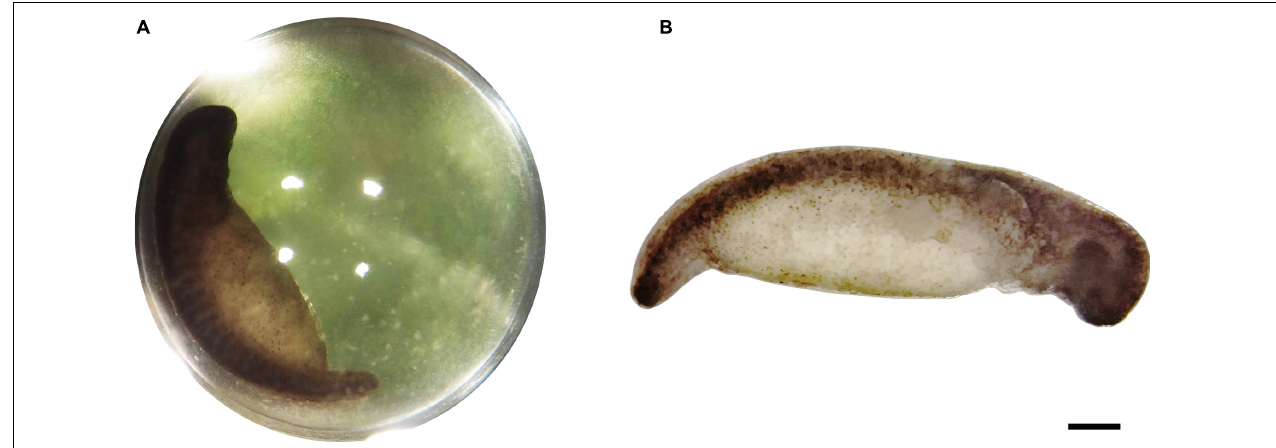
FIGURE 1 | Typical stage 33 A. maculatum embryo from these experiments. (A) Single egg capsule containing stage 33 embryo. Green hue is from intracapsular algae. (B) Decapsulated stage 33 embryo. Scale bar: 1 mm.